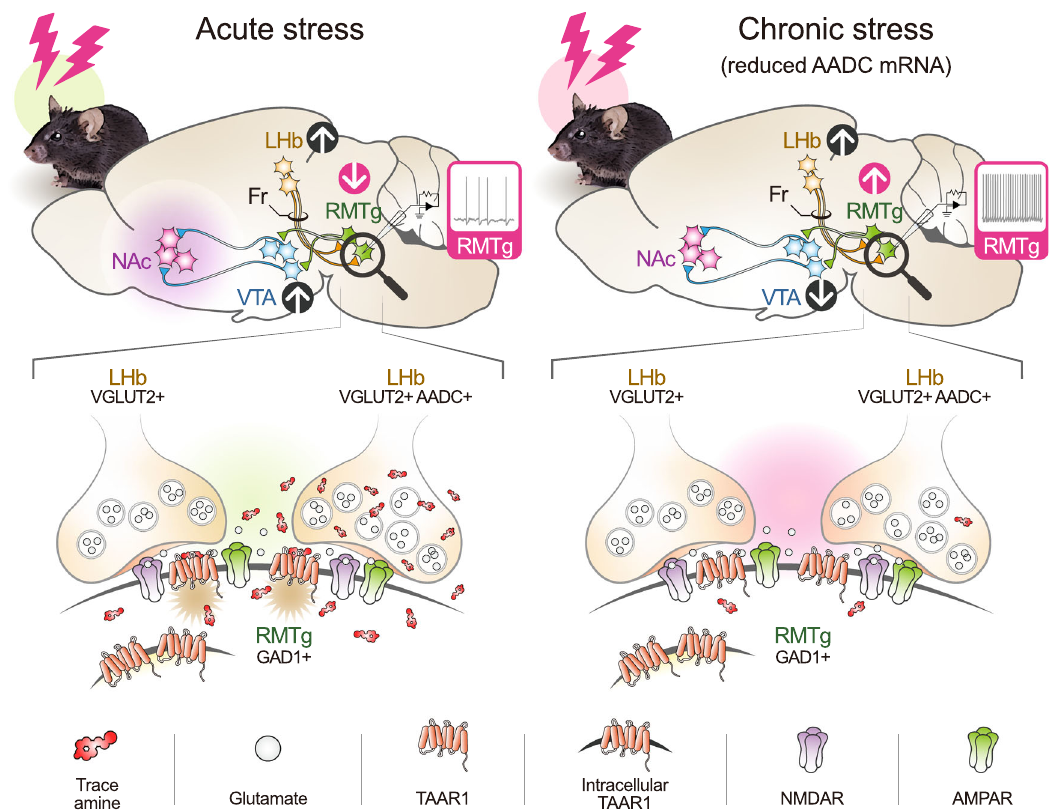
Fig. 7 | Schematic illustration of the suggested role of LHb D-neurons. LHb D-neurons project to RMTg GABAergic neurons and are activated by acute stress. Acute stress evokes trace amine release from LHb D-neurons to RMTg GABAergic neurons, leading to neuronal inactivation via TAAR1-mediated trace aminergic signalling. As the effect of trace amines overrides the excitatory glutamatergic